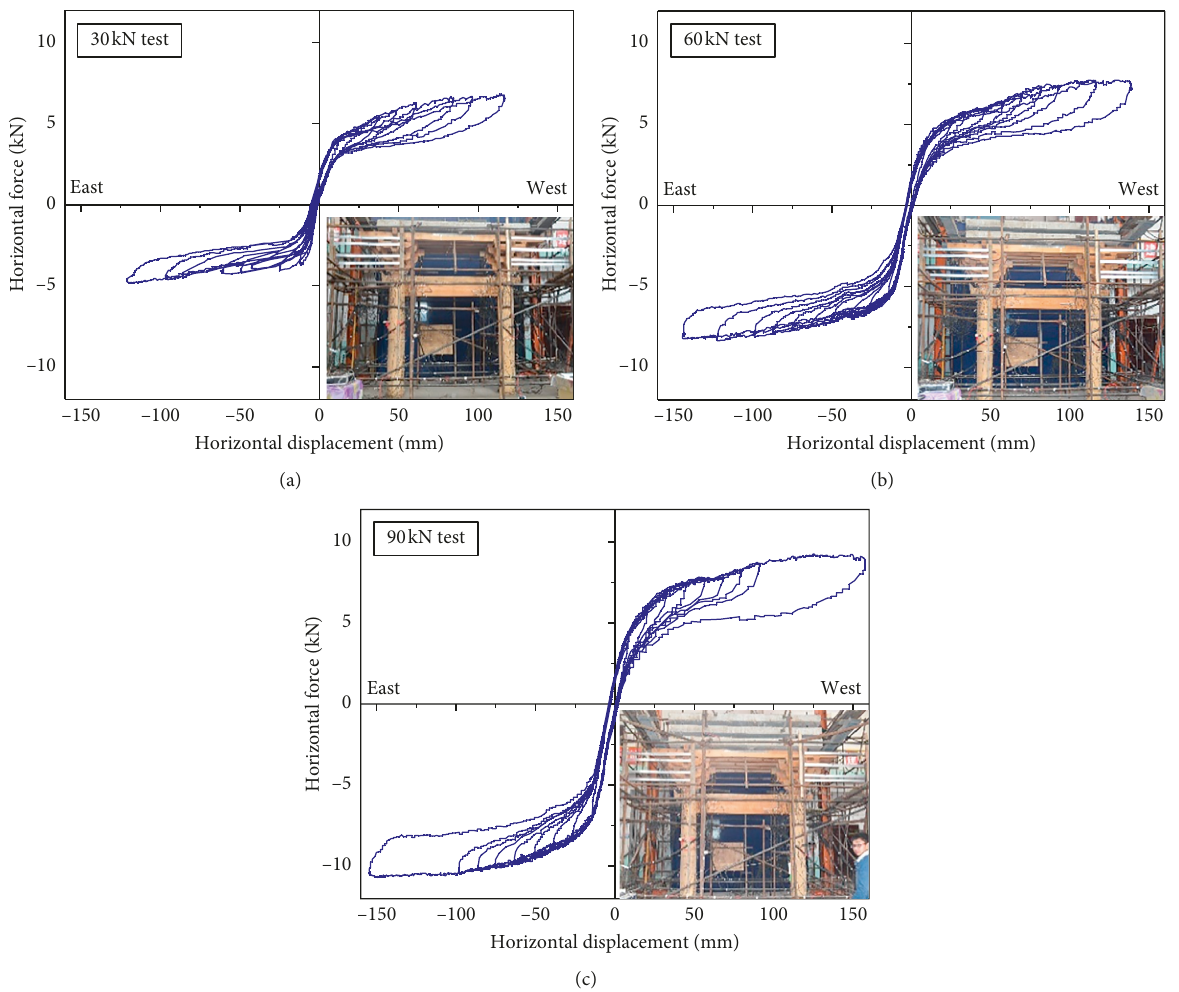
Figure 7: Hysteretic curves under three vertical loading grades. (a) Vertical load: 30kN, (b) vertical load: 60kN, and (c) vertical load: